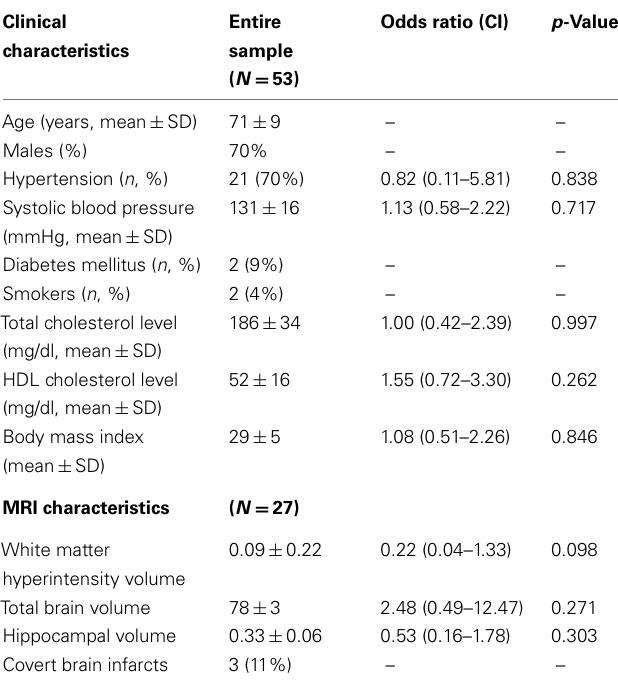
Table 1 | Baseline clinical and MRI characteristics in entire sample and comparison between cases ( N = 12) and controls ( N =